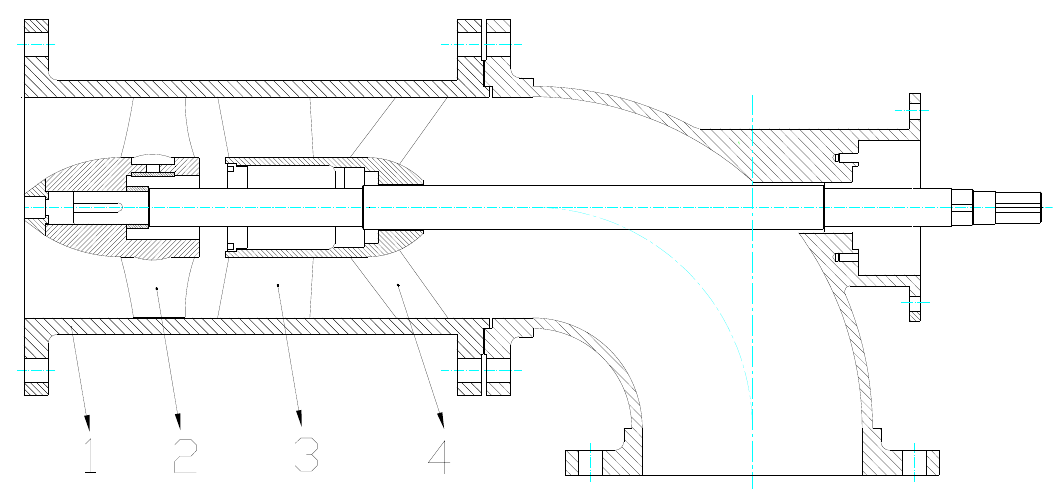
Figure 1. Two-dimensional diagram of the axial-flow pump. 1. Pipe 2. Impeller 3. Guide vane 4. Guide vane support plate. Table 1. Main geometric parameters of the model pump.